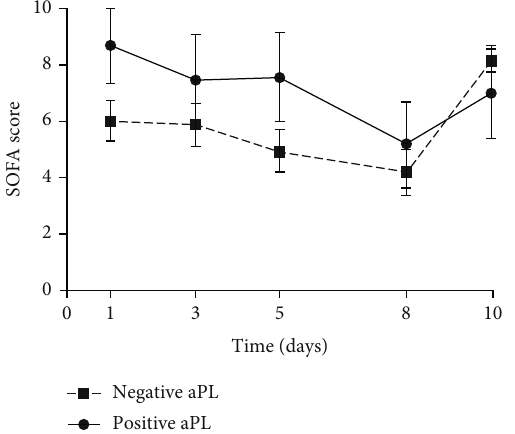
Figure 4: Evolution of SOFA score among aPL positive and aPL negative